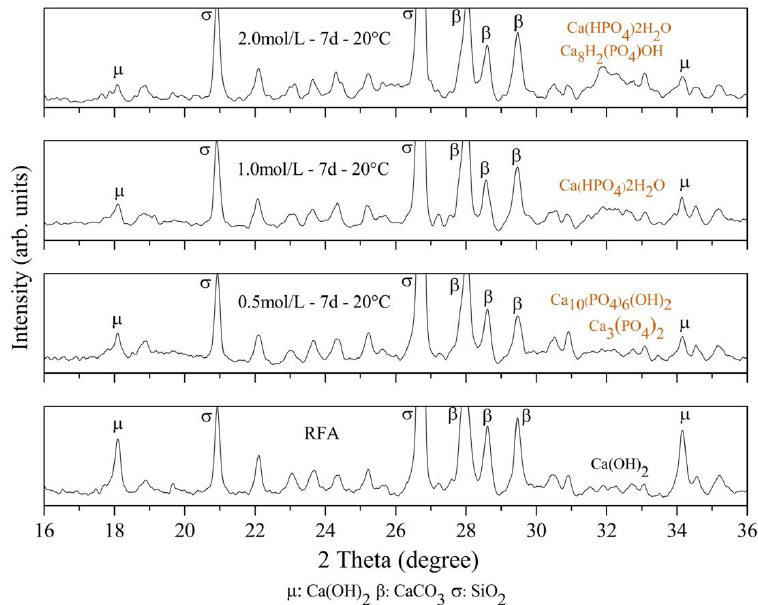
Figure 8. XRD patterns of the RFA treated with 0.5, 1.0 and 2.0 mol/L DAP solution.